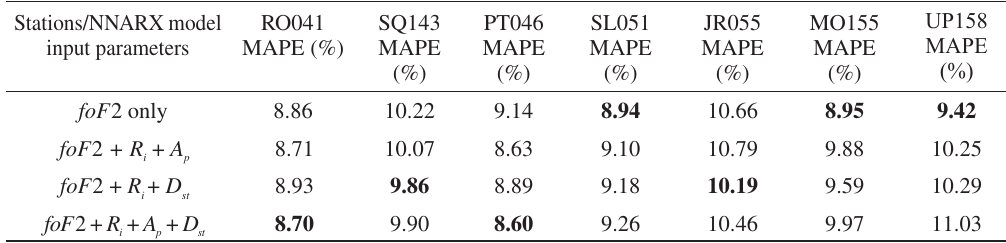
Table V. MAPE (%) at different ionospheric stations for February 1986.